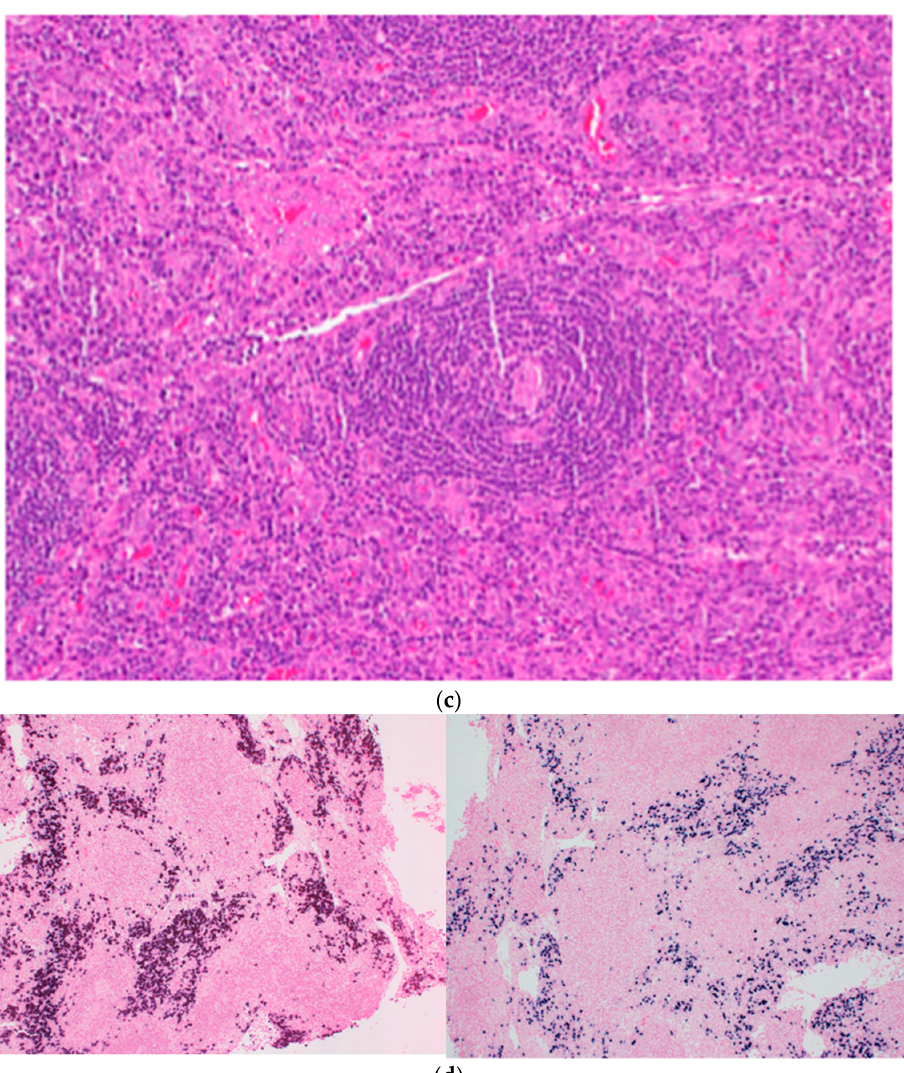
Figure 1. ( a ) Reticulin stain of bone marrow showing focally increased megakaryopoiesis (e.g., blue arrows) with little fibrosis (e.g., black arrow) (×40). ( b ) Regressed germinal centers (rGCs), interfol- licular high endothelial vessels (HEV) and plasmocytosis (hematoxylin and eosin staining × 200). ( c ) “Onion skinning" created by expanded mantle zones with concentrically arranged lymphocytes around the regressed GC (hematoxylin and eosin staining × 100). ( d ) Immunohistochemistry (ICH, × 100) staining for kappa ( right ) and lambda light chains ( left ). Ig Kappa:Ig Lambda = 1:5.